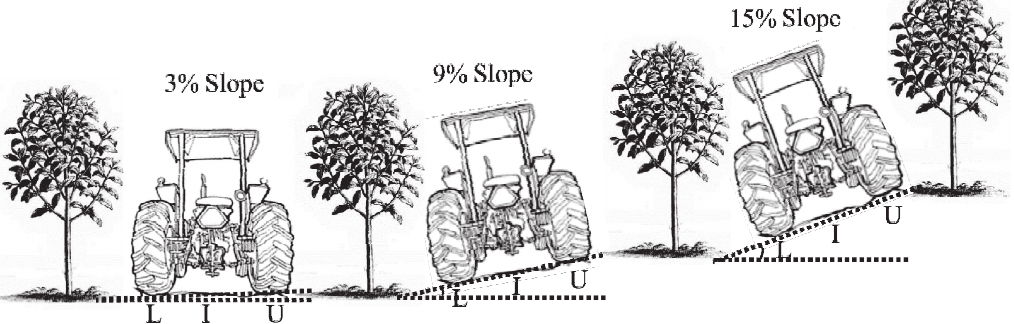
Figure 1. Schematic representation of the sampling points in the coffee row with three slopes (3, 9 and 15 %). L: lower track, I: inter-row and U: upper